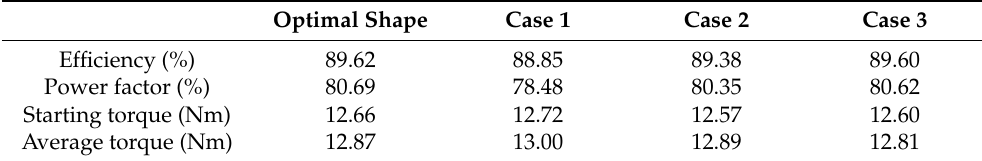
Figure 9. Loss for training data and validation data in Case 3. Table 7. Comparison of results for Type 3-1 optimal and predicted shapes in Cases 1, 2, and 3. Optimal Shape